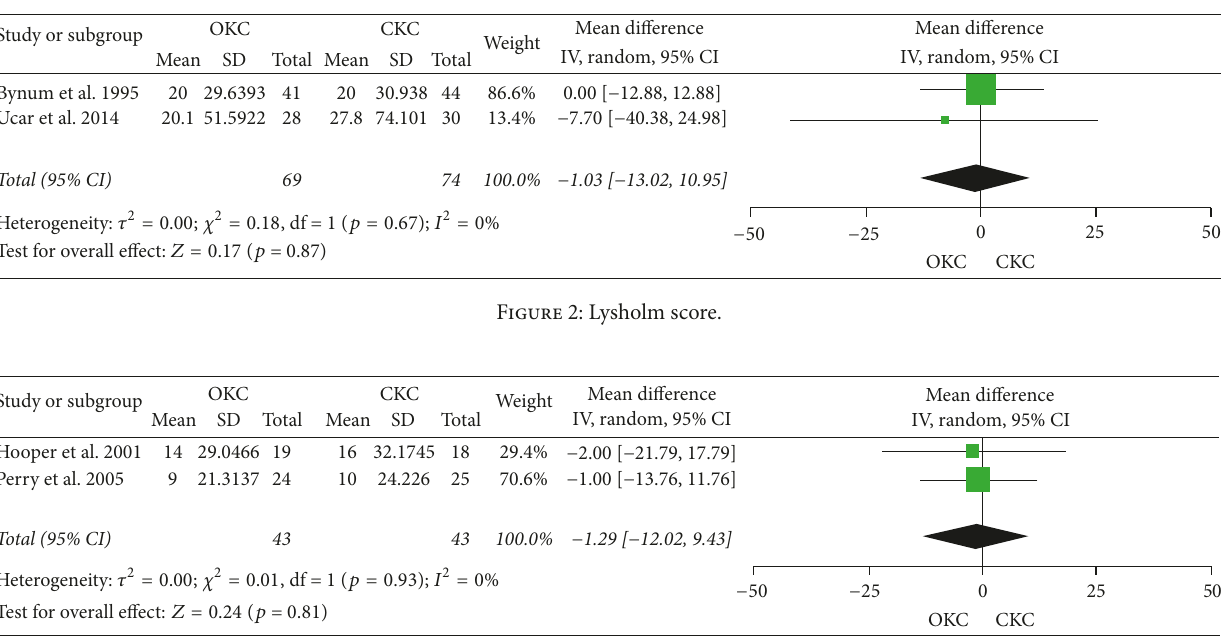
Figure 3: Hughston